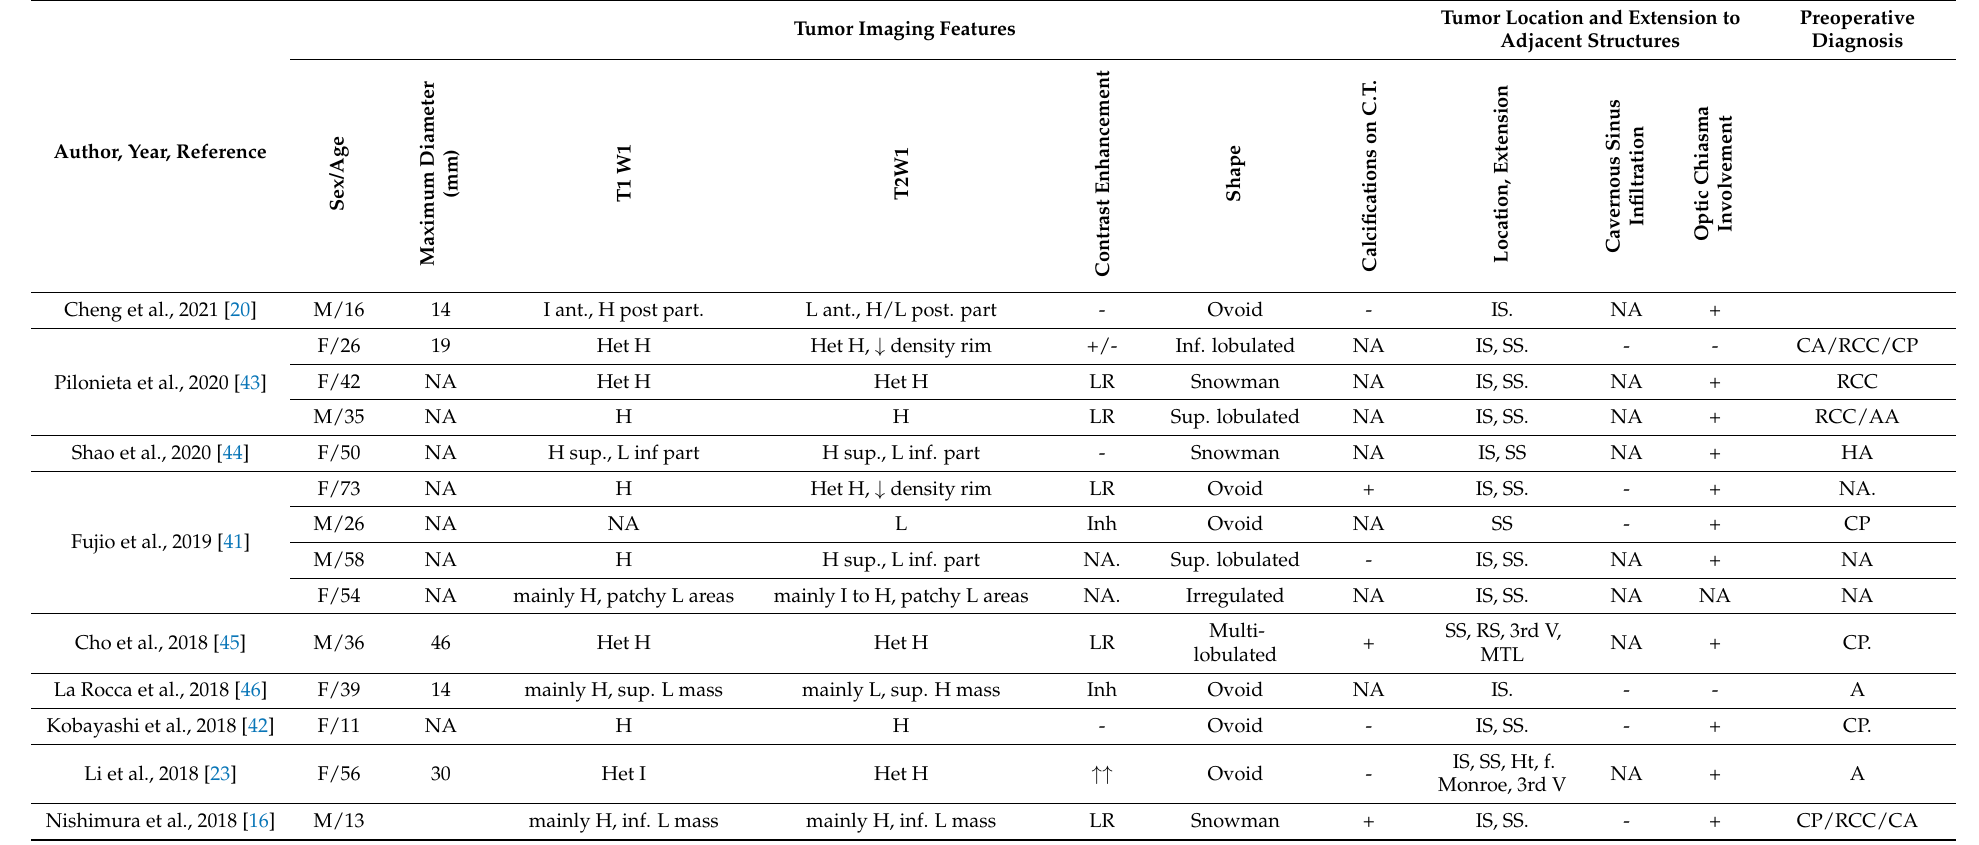
Table 1. Literature review of the sellar xanthogranulomas imaging features. Abbreviations: A = adenoma; ant. = anterior; CA = cystic adenoma; Ci = caved in; CP = craniopharyngioma; CT = computed tomography; DA = degenerative adenoma; En = enlarged; Er = erodated; F = female; f. Monroe = foramen of Monroe; Ge = germinoma; HA = hemoragic adenoma; H = high intensity; Hetero = heterogeneous intensity; Homo = homogeneous; I = isointensity; inf. = inferior; Inh = inhomogenous; Ir = irregular; IS = intrasellar region; L = low intensity; LR = linear rim enhancement; Ly = lymphoma; M = male; Me = meningioma; Mt = metastasis; MTL = mesial temporal lobe; NA = not available; N = normal; post. = posterior; RCC = Rathke cleft cyst; RS = retrosellar region; post. = posterior; SS = suprasellar region; SSC = suprasellar cistern; sup. = superior; T1WI = T1-weighted; T2WI = T2-weighted; TC = tuber cinereum; “+” = present; “-“= absent; “+/-“= slight/mild/faint; ↓ = diminished; ↑ = significant; 3rd V = third